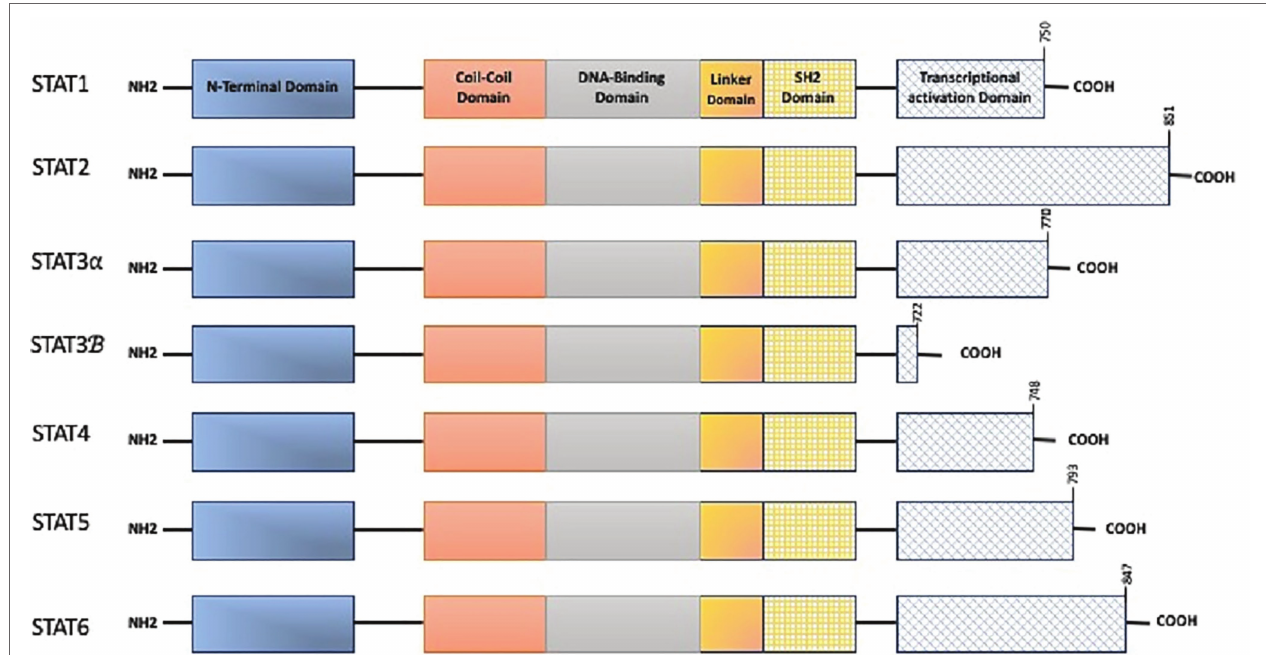
FIGURE 1 | The structure of signal transducer and activator of transcription (STAT) family. A full-length stat consists of N-Terminal domain (required for STAT oligomerization and stabilization on DNA), Coiled-Coiled domain (needed as a nuclear localization signal for stimulation), DNA binding domain (binds DNA elements), linker domain, src homology 2 domain (SH2: mediated homo or heterodimer formation, bind transcriptional activation domain of adjacent STAT monomer), and C-terminal transcriptional activation domain (TAD: Y and S within the C-terminal are the phosphorylation